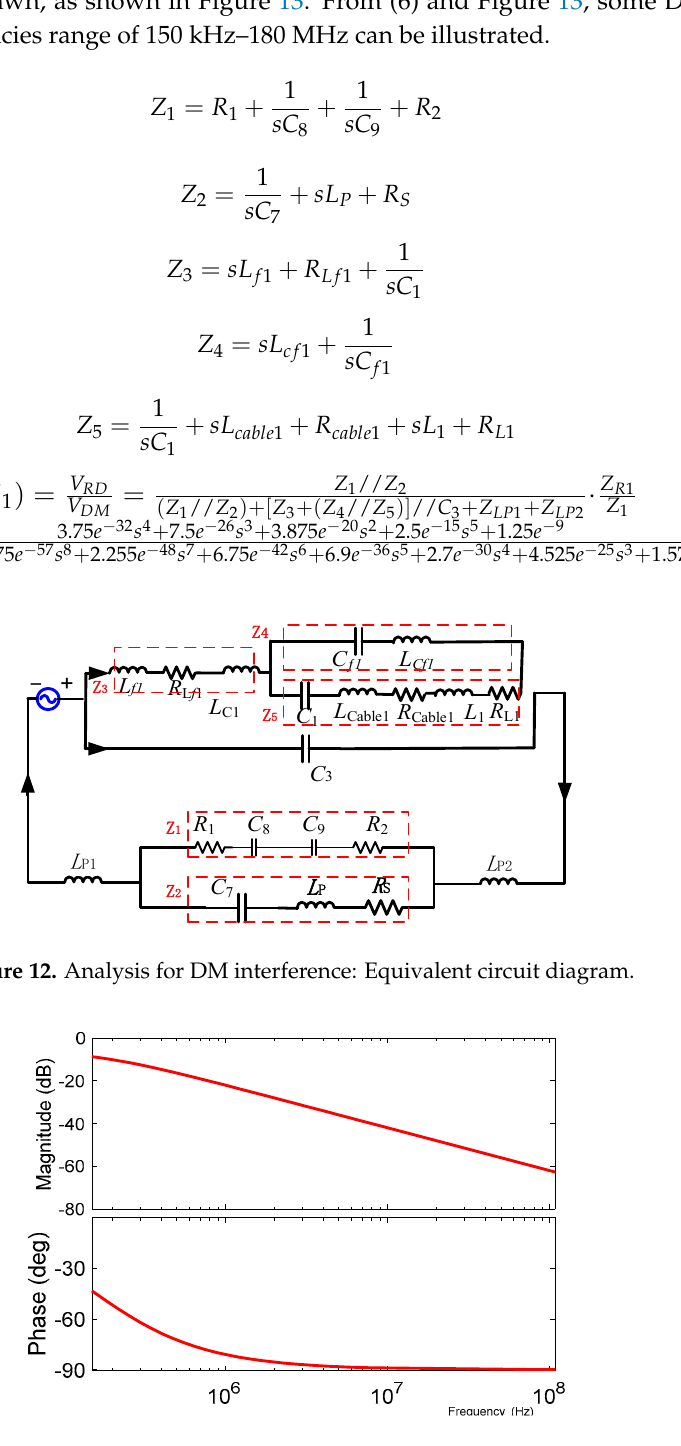
Figure 13. Bode-diagram for DM interference.